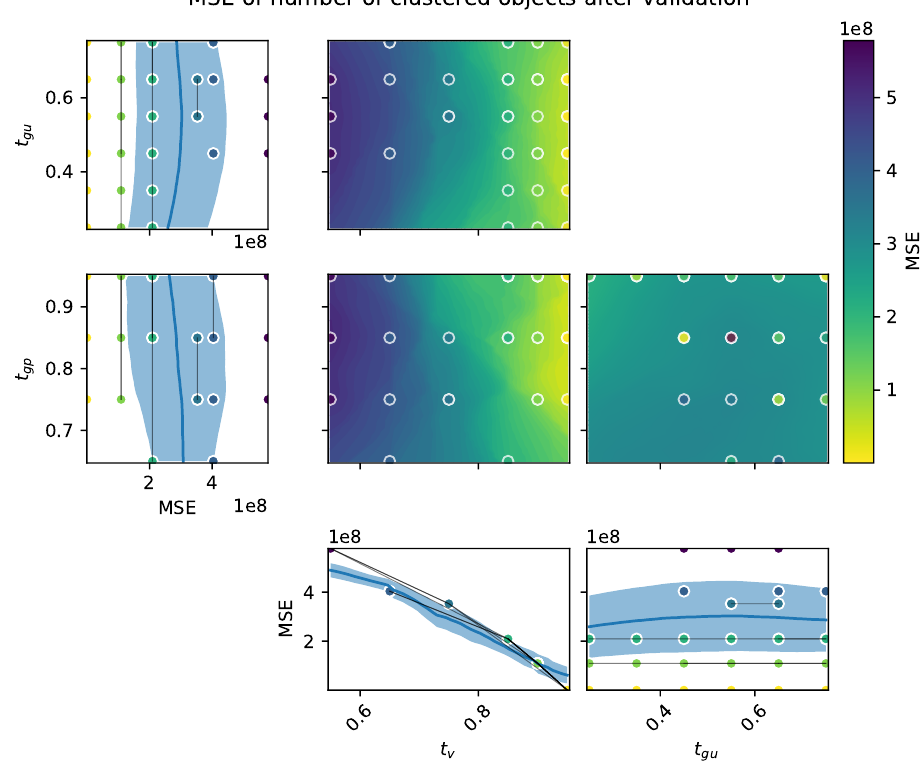
Figure A1. MSE of the number of validated objects as a function of the simulation hyperparameters after one step of the simulation. The larger the validation threshold t v , the smaller the